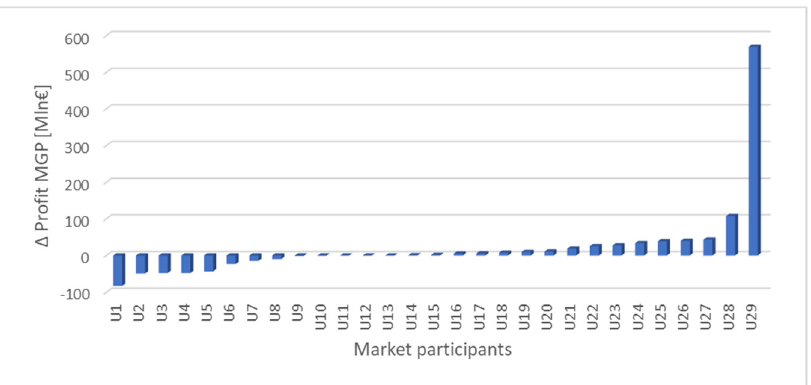
Figure 15. MGP profit increase after the introduction of the RR auction for each market participant. Figure 16 refers to the respective balancing capacity contracted in RR auction by each market operator.